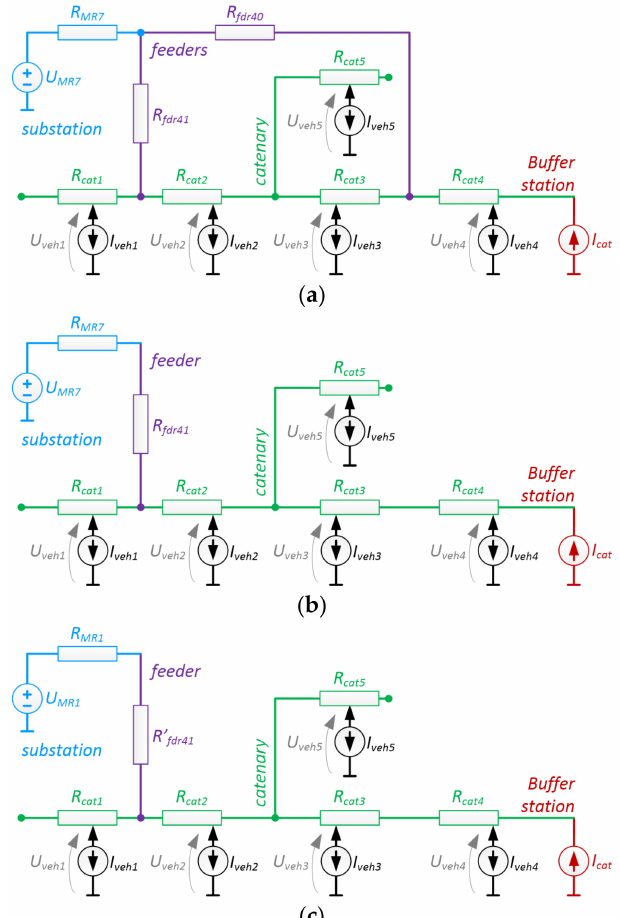
Figure 2. Equivalent electric circuit of the analyzed trolleybus power section during different tests: ( a ) normal supply, battery assisted trolleybuses in operation (weeks 1 and 2), ( b ) disconnected feeder 40 (weeks 3 and 4), ( c ) disconnected feeder 40 and feeder 41 supplied from MR1-Hydro (weeks 5 and